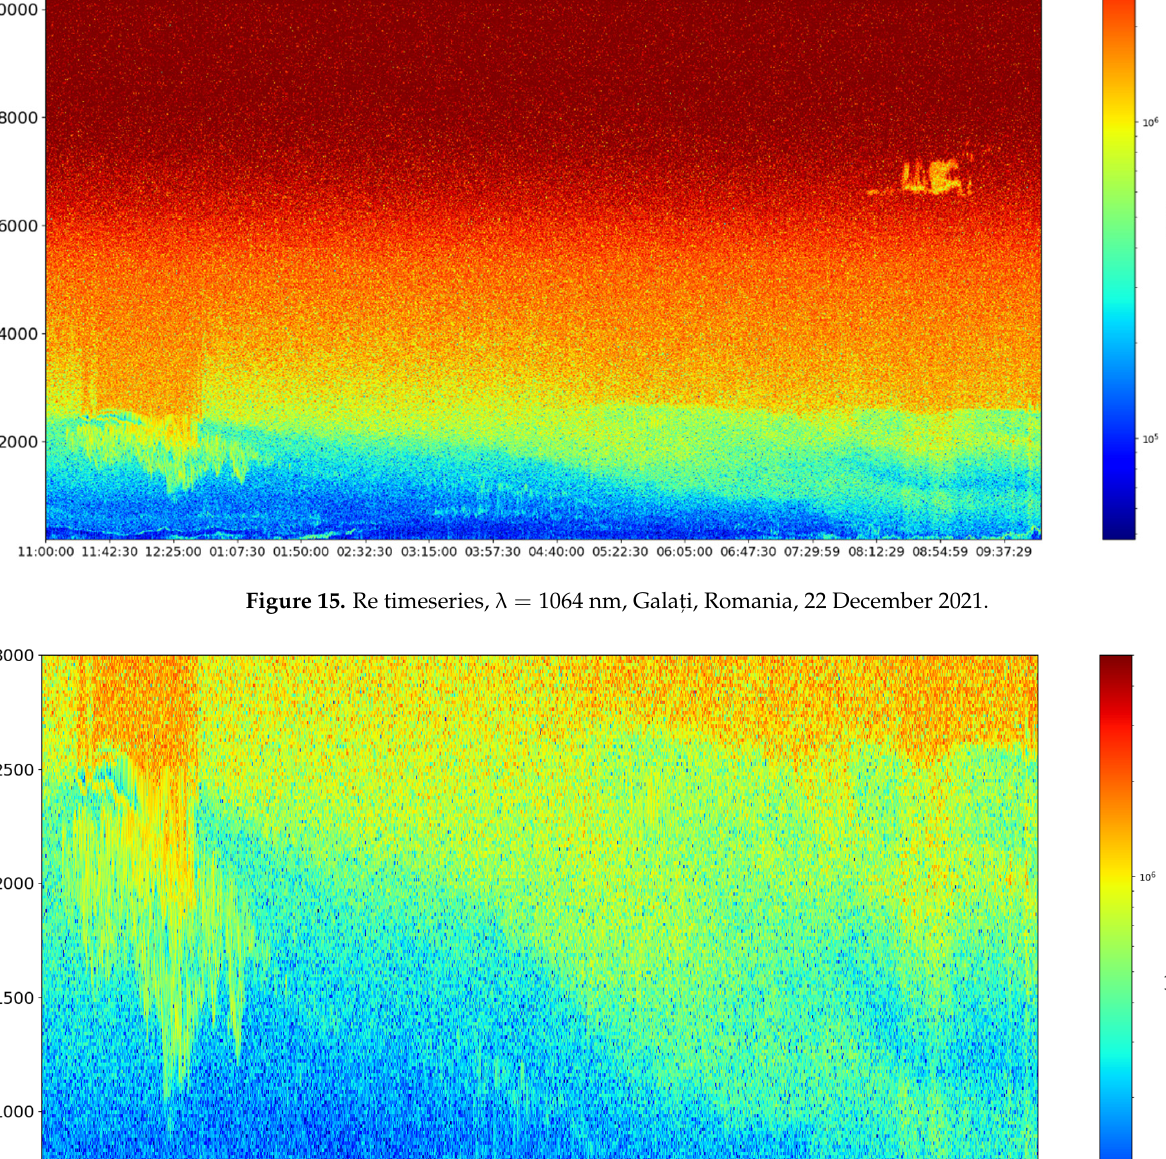
Figure 16. Zoomed-in Re timeseries, λ = 1064 nm , Gala ț i, Romania, 22 December 2021.